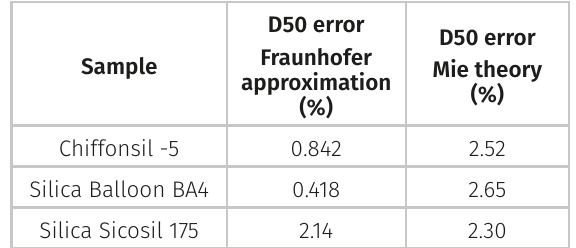
Table IV. D50 errors (%) comparison of Fraunhofer Approximation and Mie Theory methods for silica